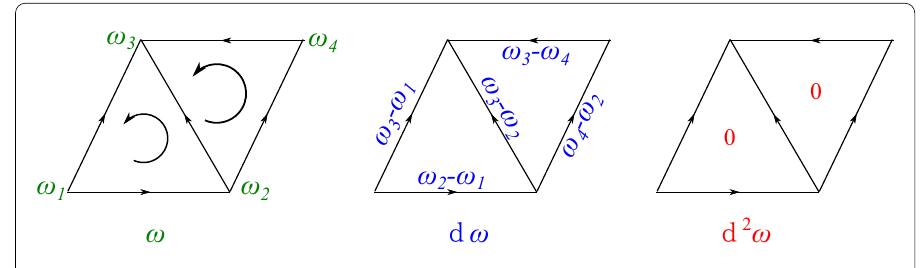
Fig. 28 An arbitrary discrete differential 0-form ω with (cid:18)(cid:18) ω ,v i (cid:19)(cid:19) = ω i , and its first and second exterior derivatives d ω and d 2